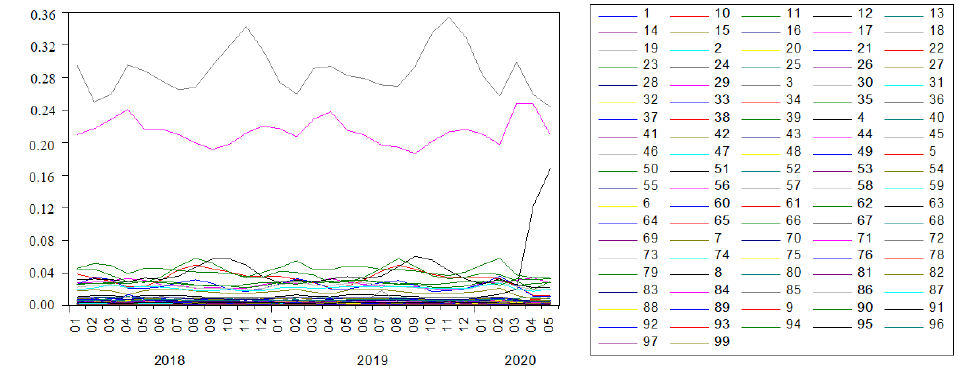
Figure 2. E.U. Import Shares of Products by year. Source: own investigation.